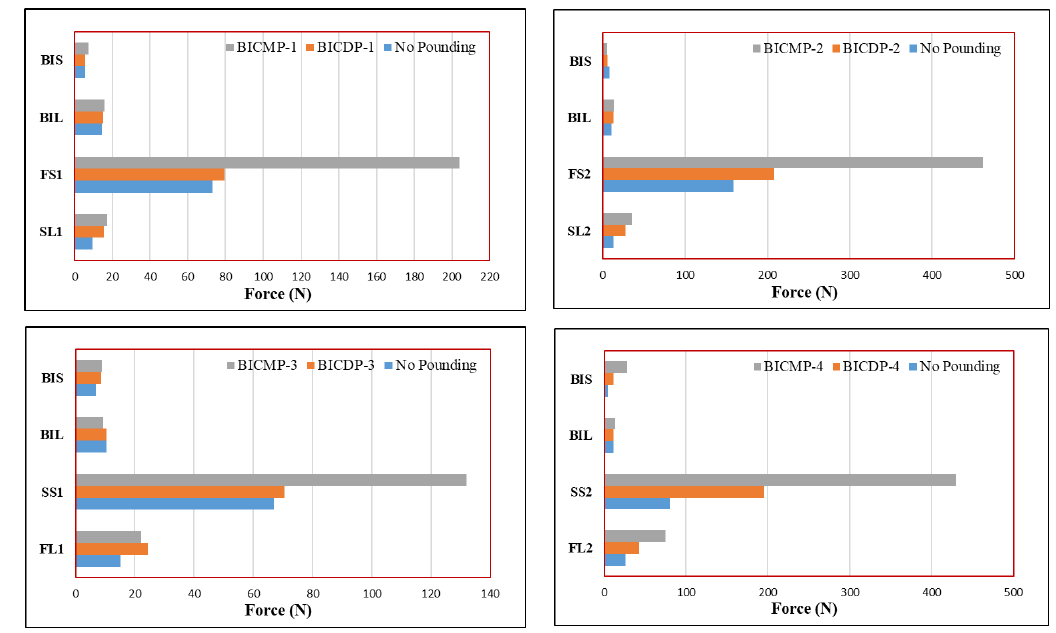
Figure 12. Maximum horizontal force in different frequency base-isolated models. Table 12. The pounding effect between different frequency base-isolated